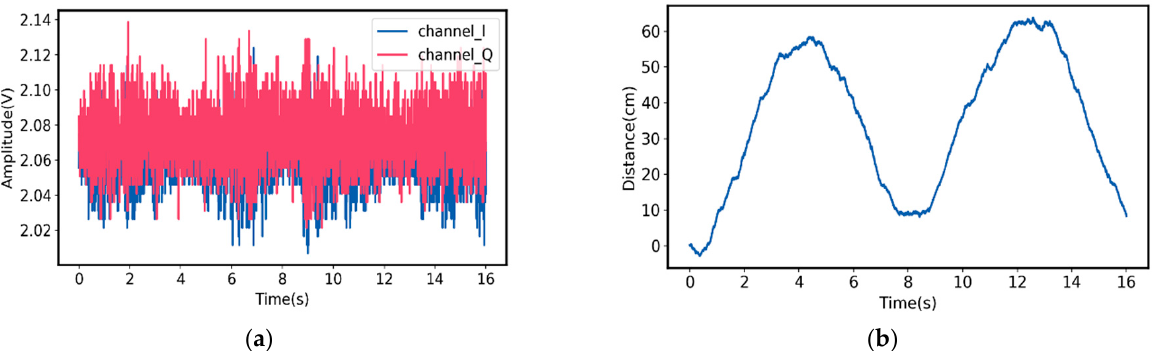
Figure 11. ( a ) Measured I- and Q-baseband signals for Target A motion at 24.3 GHz; ( b ) measured relative moving distance of Target A [50].